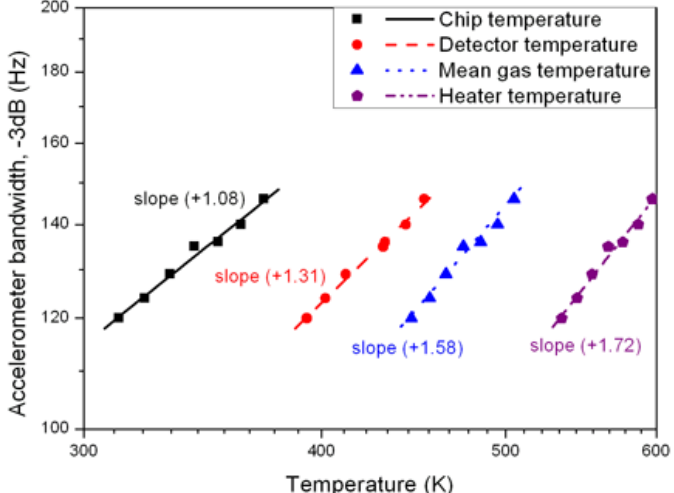
Figure 11. Sensor bandwidth vs. chip temperature, detector temperature, mean gas temperature and heater